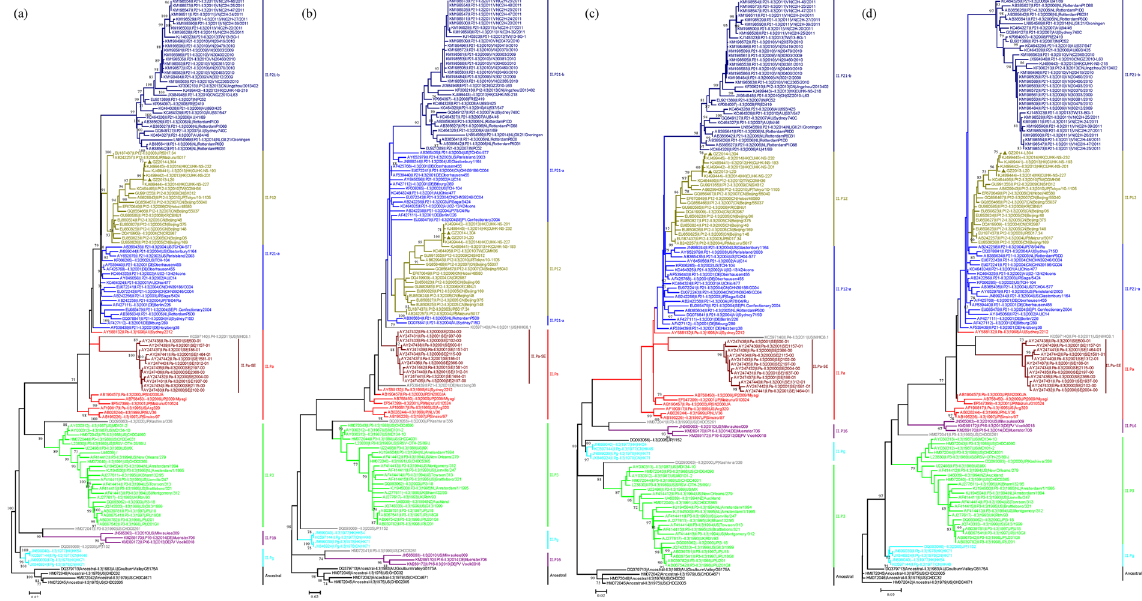
Figure 3. Phylogenetic trees of ORF2-GII.3 recombinants based on nucleotide sequences of the VP1 encoding region and its subregions: ( a ) VP1, ( b ) S domain, ( c ) P domain, and ( d ) P2 subdomain. Maximum likelihood trees were constructed using PhyML 3.0 with the general time-reversible (GTR) substitution models by jmodeltest 2 program. Numbers at the nodes indicate supporting bootstrap values (%) for 1000 resampled datasets, and only values greater than 70% are shown. The scale bar represents the unit for the expected number of substitutions per site. Guangzhou NoV strains are designated by location, year, and identification number (indicated by the black diamond). Reference sequences are indicated by their accession numbers, genotypes, years, countries, and strain names.